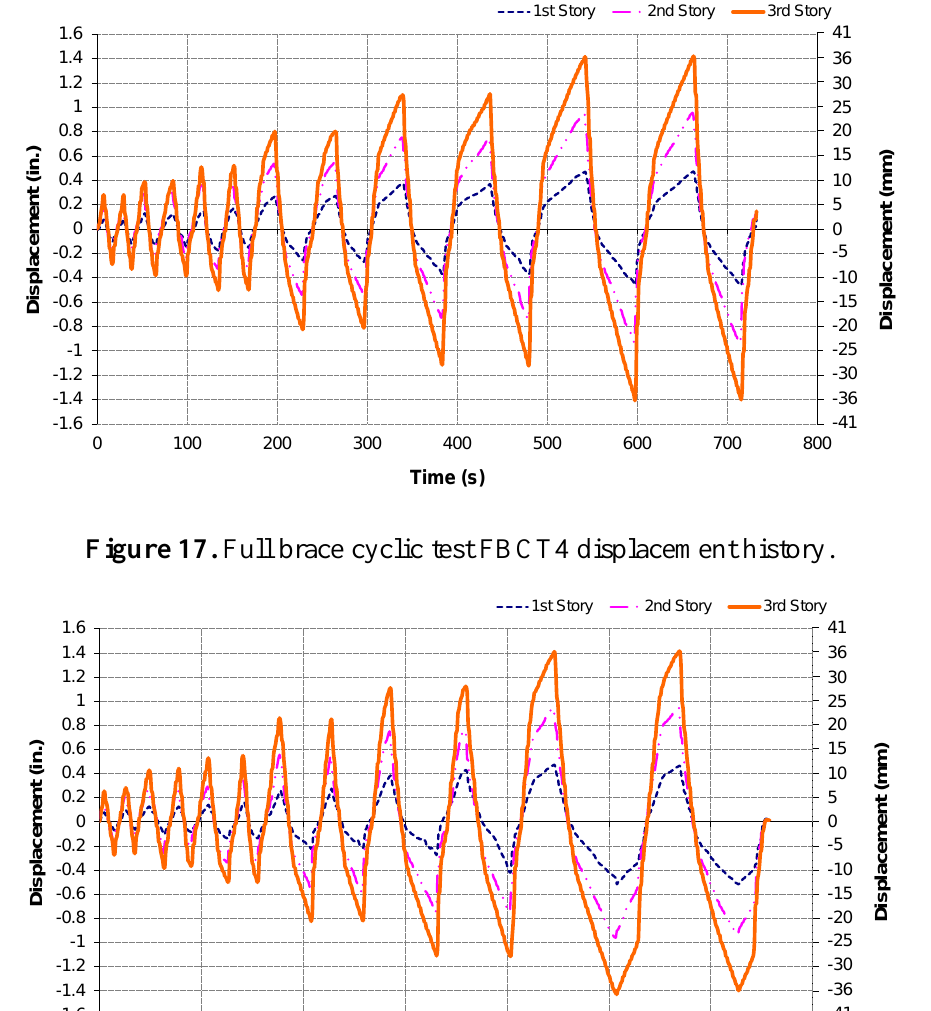
Figure 16. Full brace cyclic test FBCT2 displacement history.